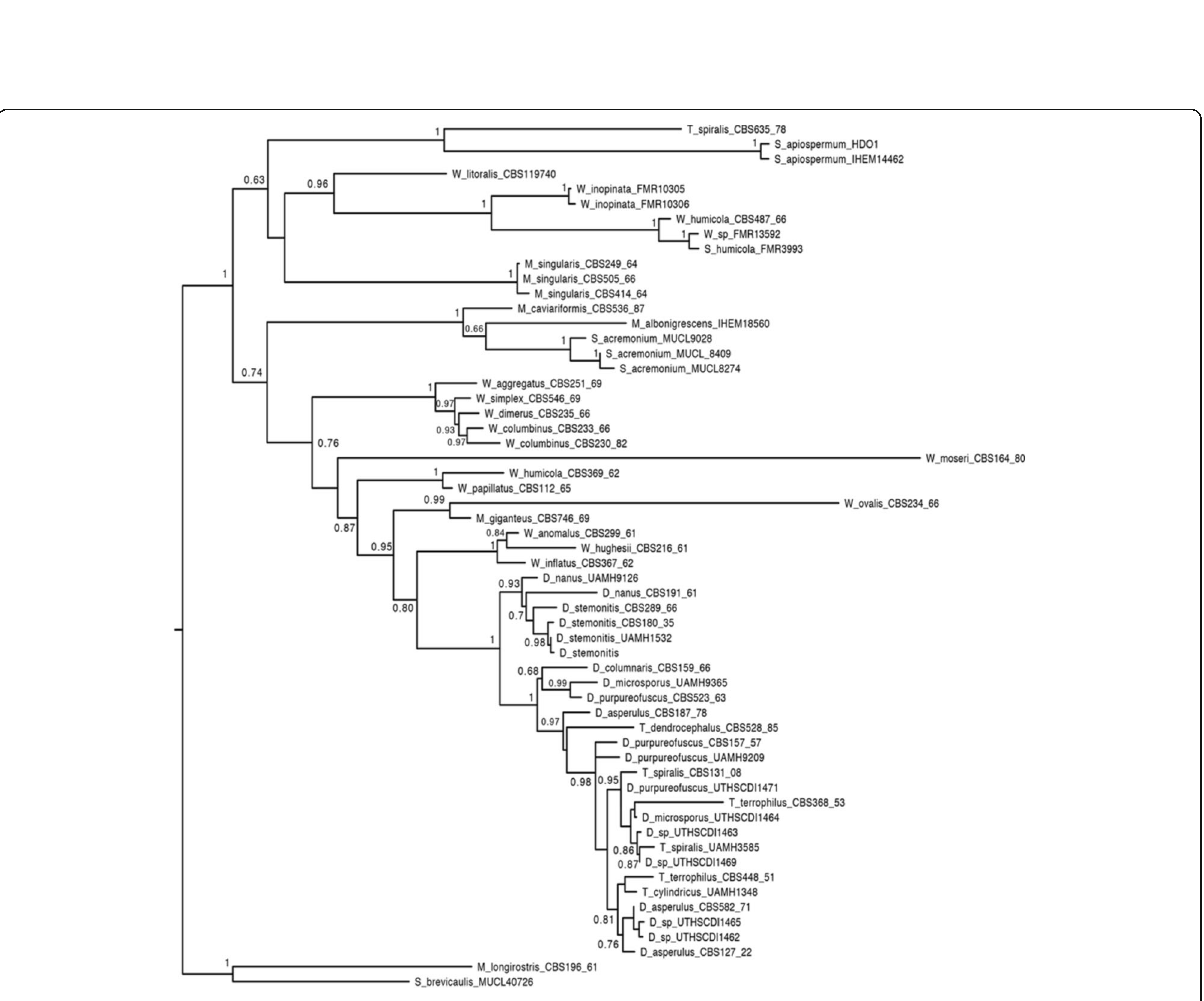
Fig. 2 Phylogenetic Analysis of S. apiospermum HDO1. Estimated relationships of S. apiospermum HDO1 with S. apiospermum IHEM 14462 and other species from the Microascaceae family. The tree shows the concatenated analysis of the Internal Transcribed Spacer, the Large Subunit and the Elongation factor gene regions. Sequences from reference strains were used (Additional file 1:Table S3). Support values represent Bootstrap support values (Maximum Likelihood)